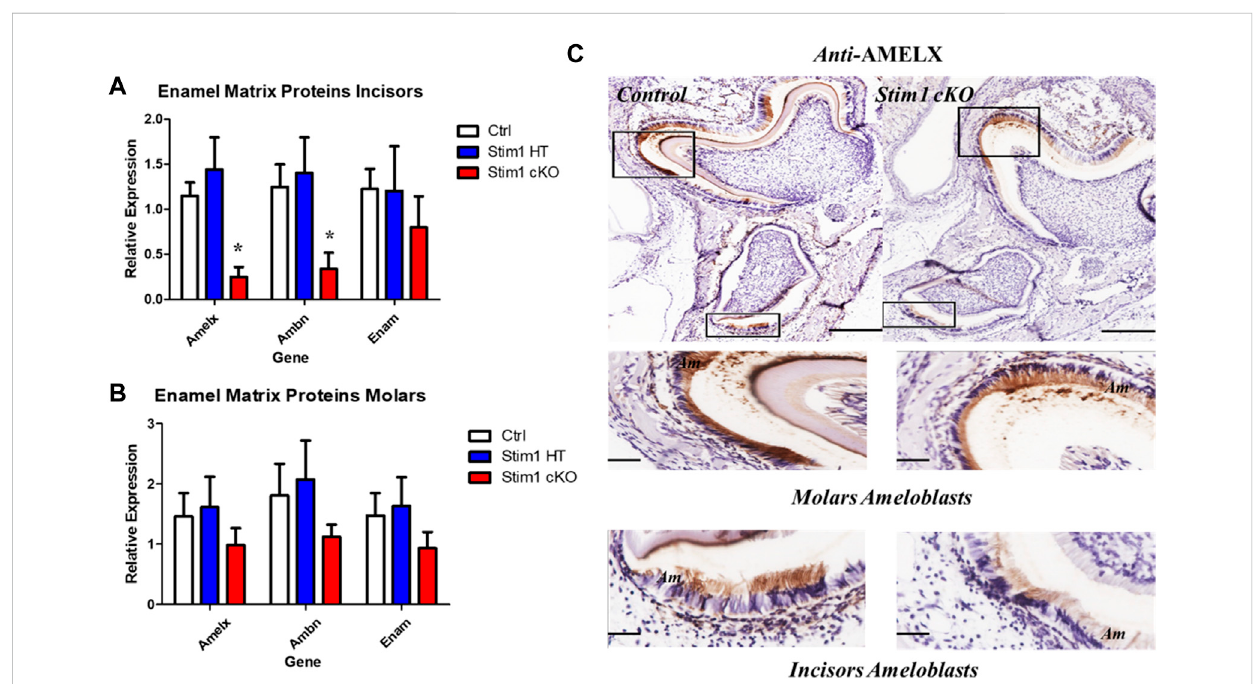
FIGURE 7 Enamel matrix genes and proteins expression analysis of Stim1 cKO mice. Gene expression analysis in incisors (A) and molars (B) ameloblasts from control andStim1 cKOmice(mean ±SEM, n =3~4miceper genotype; * p < 0.05 compared toCtrl).Ouranalysisshowedthat theexpression levelsofthe genes encoding the enamel matrix proteins AmelX and Ambn were upregulated in Stim1 cKO incisors ameloblasts compared to control. However, no signi fi cant changes were observed in the molars ameloblasts albeit having lower RNA levels of AmelX, Ambn and Enam. No clear differences were found between the Stim1 HT and Stim1 Ctrl in the expression of the main enamel genes. (C) Immunostaining of the mandibular molar and incisor tooth budsshowedreducedproteinlevelsofAmelogenininStim1cKOascomparedwithage-matchedcontrols.Thechangewasmorepronouncedinincisors ’ ameloblasts compared to molars. The rectangular areas are enlarged in the lower panels for each image. Scale bars: (C) 250 µm in the upper low mag panels and 50 µm in the lower high mag